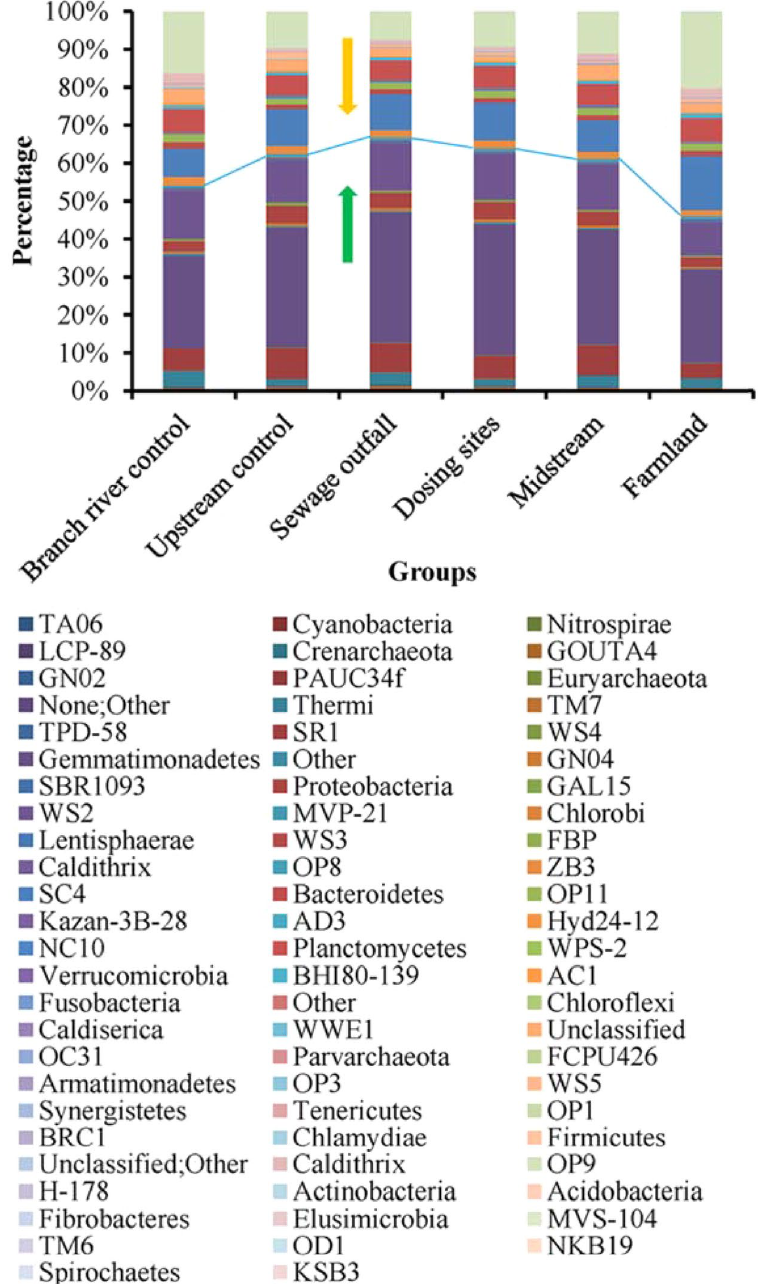
Figure 4. Microbial community composition of different groups (difference in relative abundance among phyla). Below the blue line are the phyla for which abundance increased in samples with high Cd content, and above the blue line are the phyla for which abundance decreased in samples with high Cd